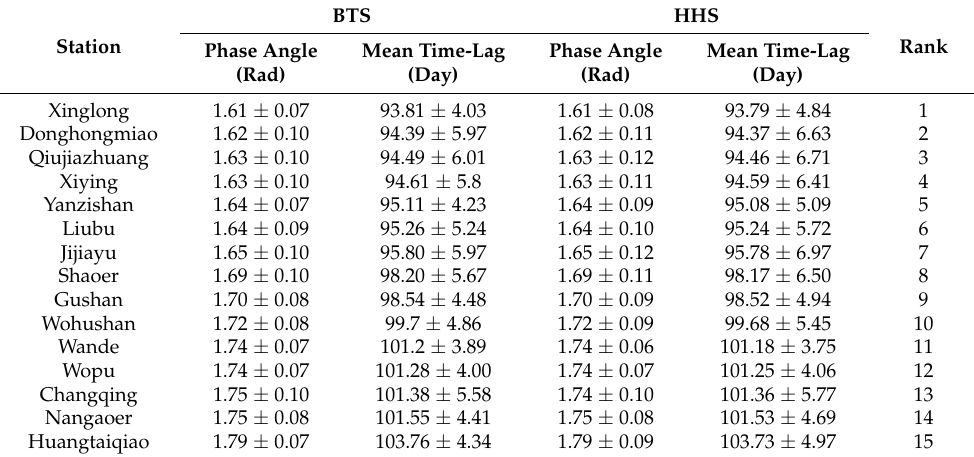
Table 2. Cross-wavelet phases and time intervals of precipitation and spring water